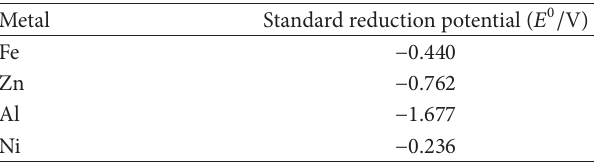
Table 1: The standard reduction potentials of different metals a